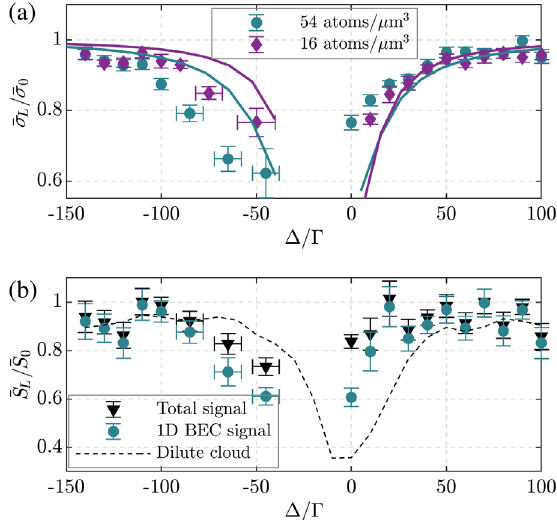
z Þ = σ 0 ð z Þ as a function of FIG. 5. Relative transverse width σ L ð z Þ the (axial) z axis of the BEC (after TOF ¼ 44 ms) with σ L ð and without σ 0 ð z Þ interaction with a 5 - μ s-long laser pulse at a detuning of (a) Δ ¼ − 392 Γ , atom number N ¼ 7450 ð 60 Þ , and saturation s ¼ 319 ð 11 Þ × 10 − 6 and (b) Δ ¼ þ 100 Γ , N ¼ 6600 ð 130 Þ , and s ¼ 708 ð 29 Þ × 10 − 6 . The laser pulse pro- pagates from left to right. The circles (triangles) represent the measurements with the light pulse triggered after 105 ð 235 Þ μ s expansion time. The error bars show the standard error of the mean. The lines show the results of simulations including thermal phase and density noise for the condensate temperature T ¼ 135 nK; see Appendix B. The shaded areas depict the standard error of the mean obtained from 100 runs of the numerical simulation. An asymmetric compression of the trans- verse width along the axial direction of the BEC is clearly observable for different mean atomic densities ρ at the start of the LIDD interaction. This behavior arises due to the nonlocality of the LIDD